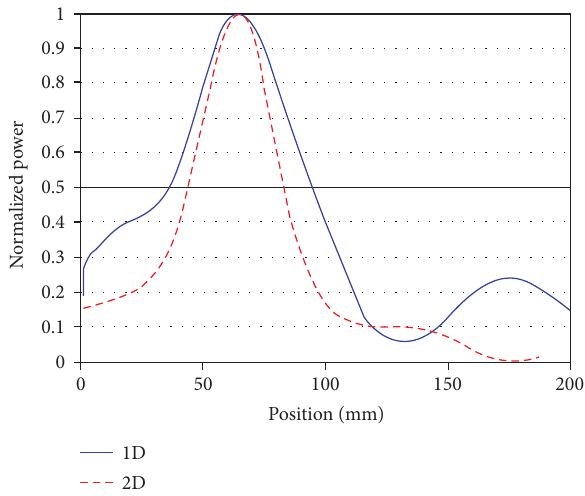
Figure 14: Power scans at focus spot distance for 1D lens and 2D lens